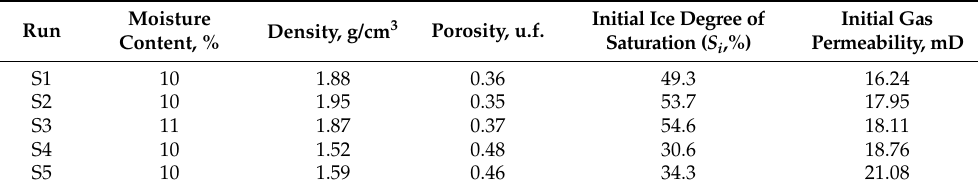
Table 2. Properties of frozen sand samples prior to hydrate